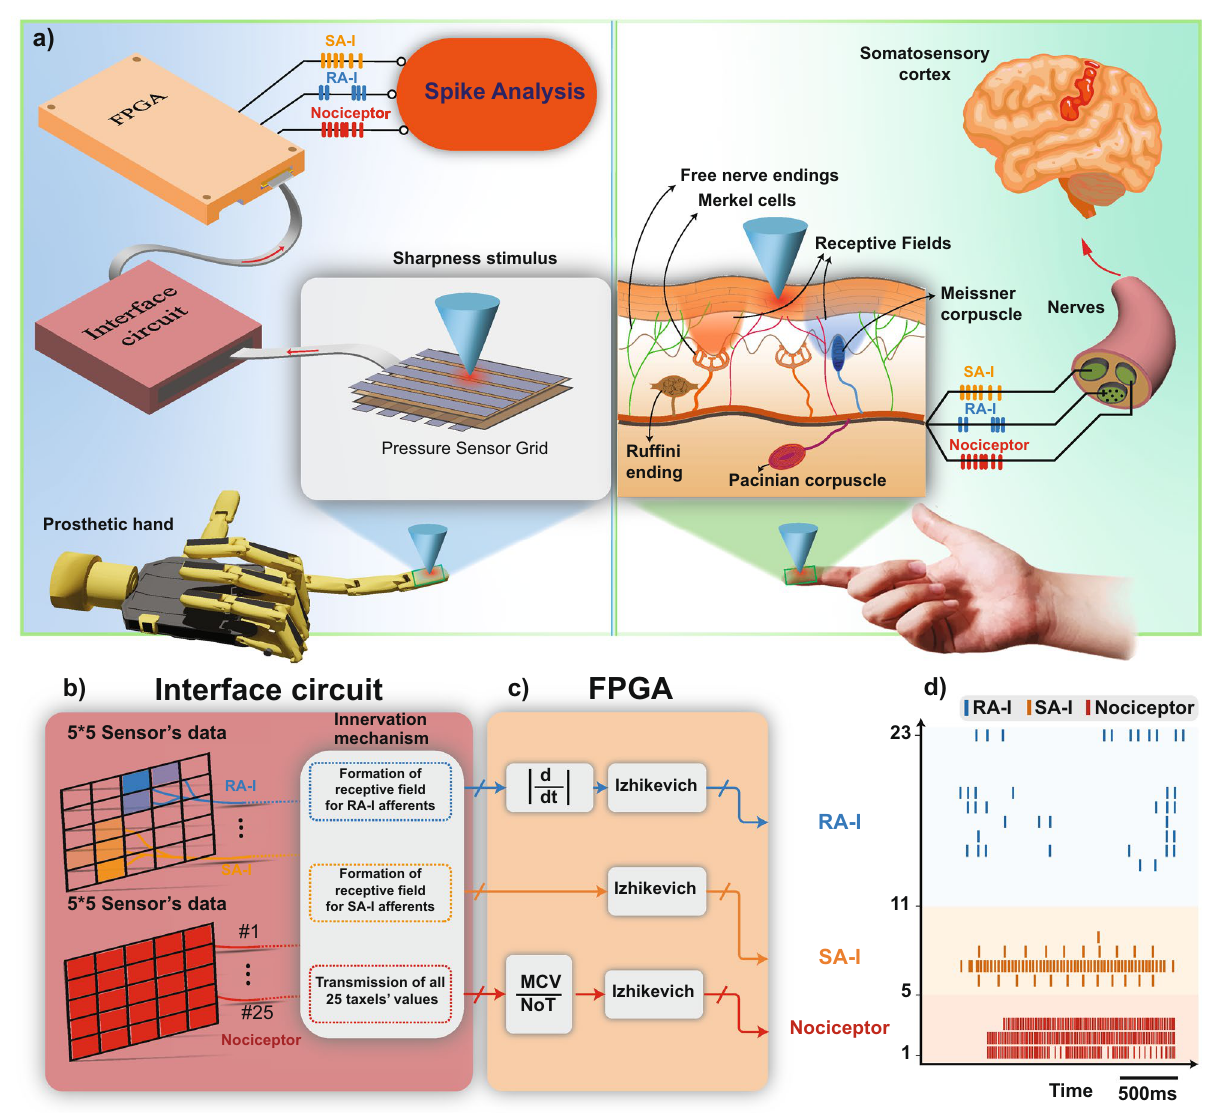
Figure 1. The proposed architecture for the FPGA-based tactile neuromorphic system. ( a )-Left: Artificial pathway on the prosthetic hand that transduces the contact events to spiking responses in the parallel computational mechanism. The pressure signal obtained from the tactile sensor is converted to the current, I, (in the interface circuit) to feed as the input to the Izhikevich digital circuit (implemented on the FPGA). ( a )- Right: Different mechanoreceptors distributed across the patch of skin. The afferent fibers transmit the tactile information obtained by the skin mechanoreceptors to the spinal cord. ( b ) The interface circuit connects the sensor array to the FPGA and performs innervation and receptive field creation for the digital afferents which are implemented on the FPGA. ( c ) The bio-inspired circuits of 12 RA-I, 6 SA-I, and 5 nociceptors are executed on the FPGA to generate the spike responses. The designed digital circuits convert the data from the interface circuit to the appropriate spike trains and send them to the PC by UART protocol. ( d ) The recorded firing patterns of the population of 23 biomimetic circuits from the FPGA for a sample of sharp